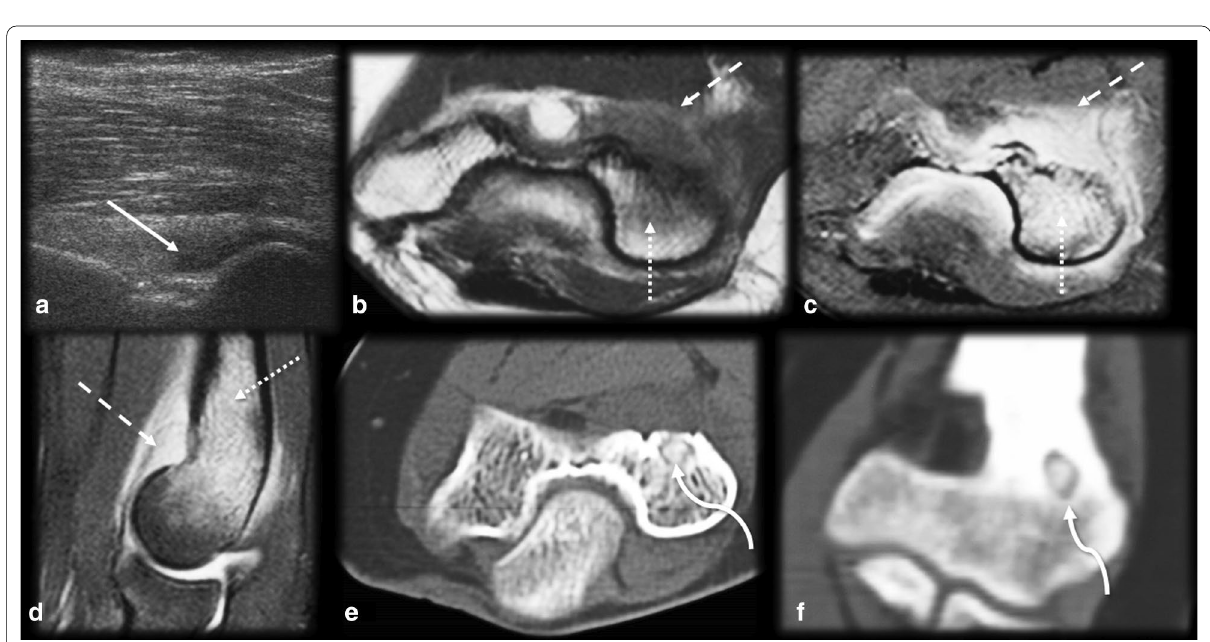
Fig. 5 Osteoid osteoma mimicking synovitis on the elbow. Female, 20 years old, with elbow pain and edema for 4 months. Ultrasound in anterior sagittal view ( a ) at the coronoid fossa level shows joint effusion (arrow). MRI T1 ( b ) and T2FS ( c , d ) show bone marrow edema (dotted arrows) and synovitis (dashed arrows). Further investigation with a CT scan ( e , f ) revealed a mineralized nidus (curved arrow) in the cancellous bone of the medial humeral